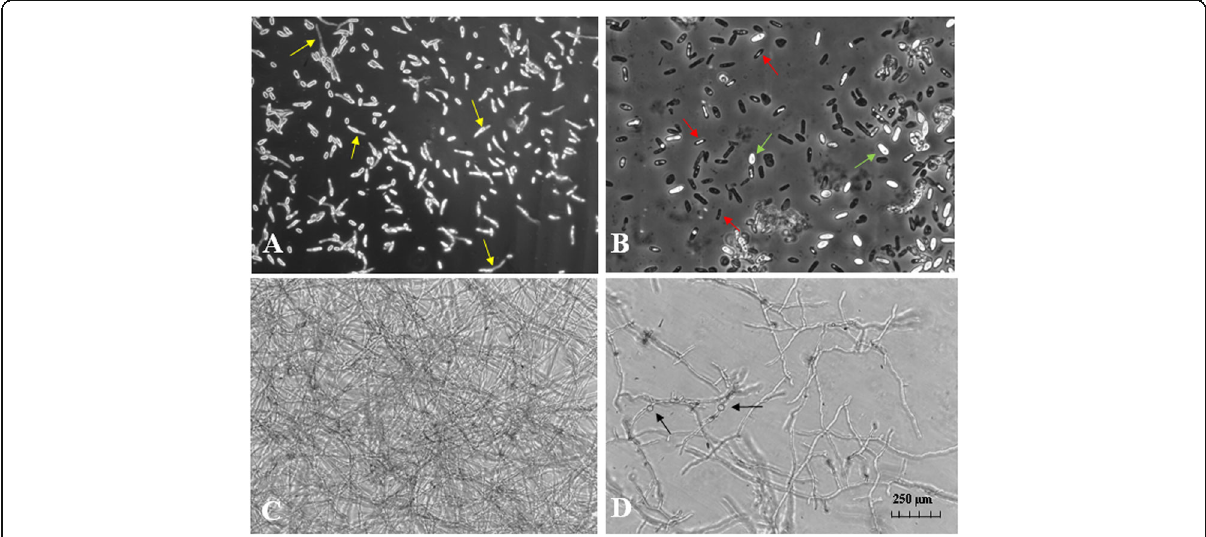
Fig. 5 Morphological effects of BE on germination of Colletotrichum musae conidia. a , c Conidial germination of control assay after 6 and 22 h, respectively; yellow arrows showed germ tube formation. b , d Conidial germination of BE assay after 6 and 22 h, respectively; red arrows showed damages in conidia, green arrows showed unaffected conidia by BE treatment, and black arrows showed chlamydospore-like